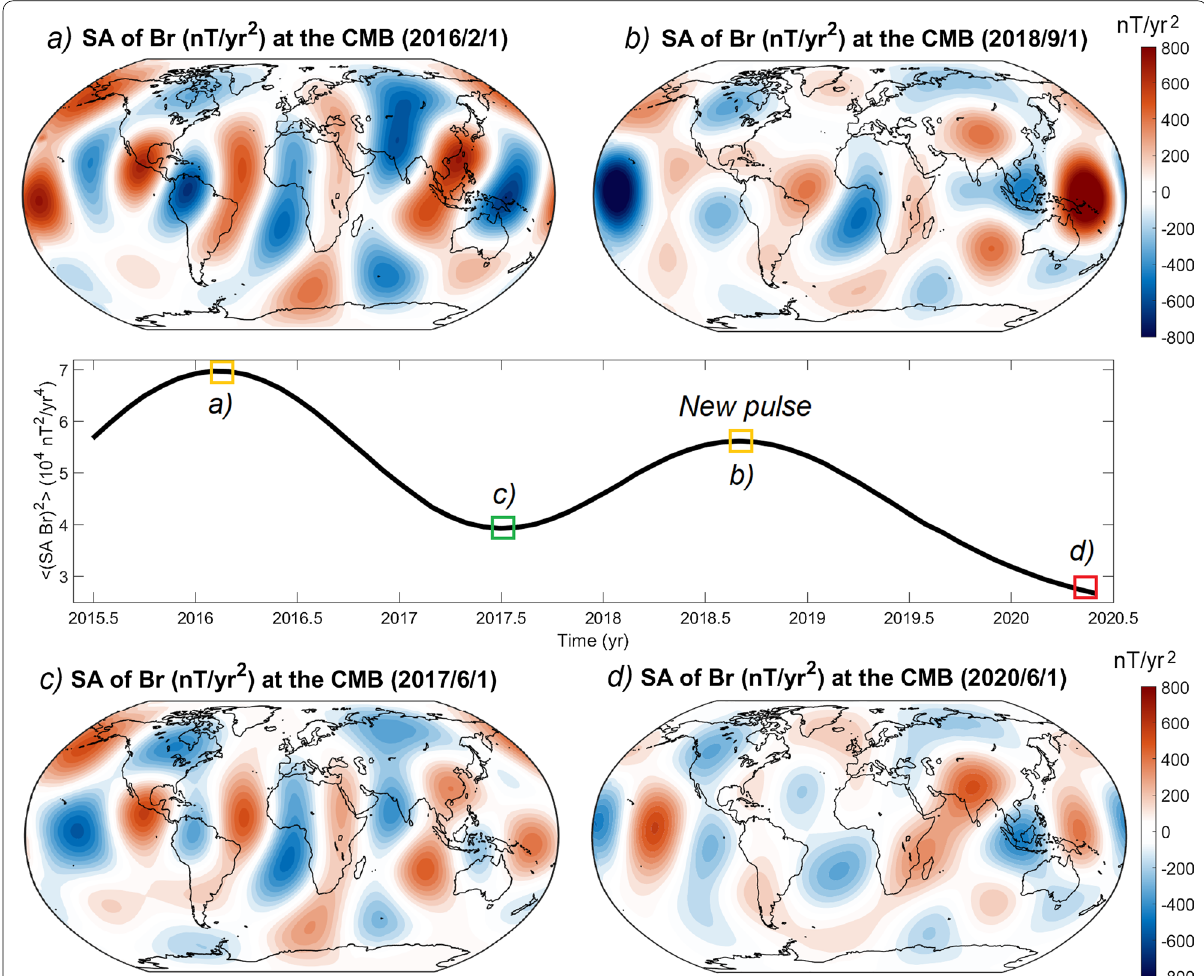
data (see “Discussion: a global view from geomagnetic models” Section of the main text for more details). Figure S2. Double linear fit of the Y‑component SV at geomagnetic observatories leading to the values of Table 1 (see main text). a and b refer to the 2017‑jerk, while c through g correspond to the 2020‑jerk. Figure S3. Yellow dots: SV of the East component Y from Swarm‑A data relocated at 440 km altitude over the indicated observatory locations (see main text for details). Red and blue curves: SV estimation from CHAOS‑7.7 model. Note that after August 2020 the changes in the curves (blue lines) from CHAOS‑7.7 are likely caused by the model regularization instead of the data (see “Discussion: a global view from geomagnetic models” Section of the main text for more details). Figure S4. SA power for each harmonic coefficient from the CHAOS‑7.7 model until degree n 8 at the CMB. Vertical blue bands indicate the = epochs of the reported jerks. Note that after mid‑2020 the SA power curves from CHAOS‑7.7 are biased by the model parametrization instead of the geomagnetic data providing unreliable values (see “Discussion: a global view from geomagnetic models” Section of the main text for more details).